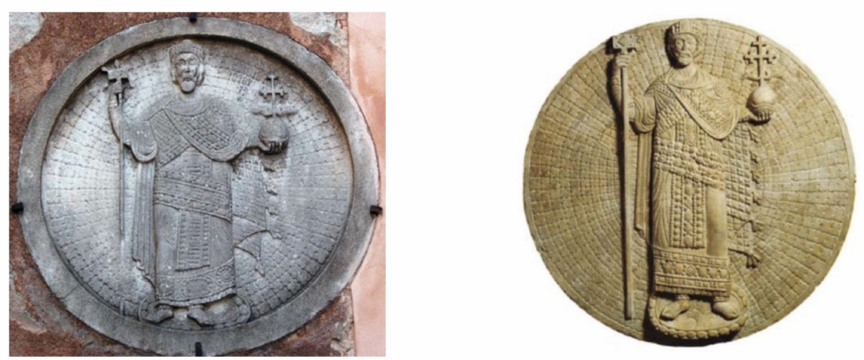
Figure 3. Unknown Emperors; Figural Roundels; unknown date and provenance; now found at the Campiello Angaran, Venice (L) and Dumbarton Oaks (R). Published in [15] ( DOC , p. 149), [16,17] (Figures 1 and